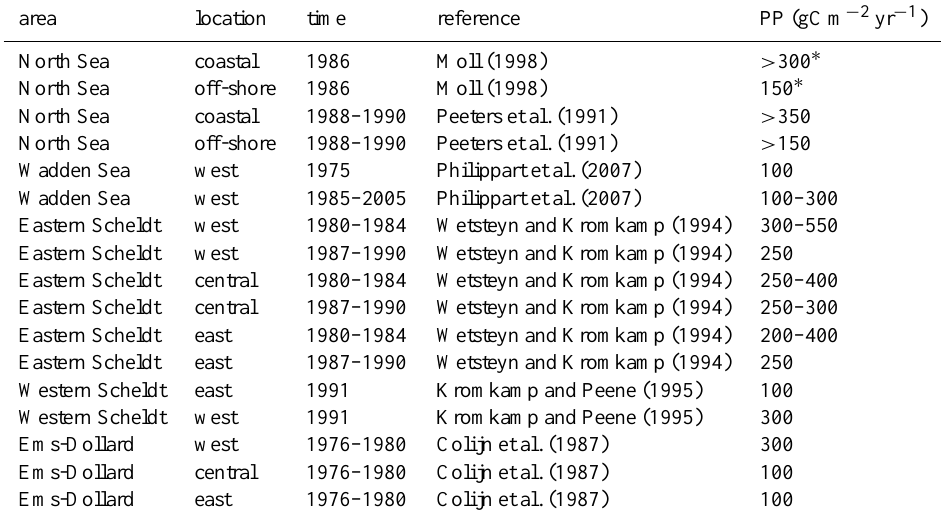
Table 1. North Sea primary production